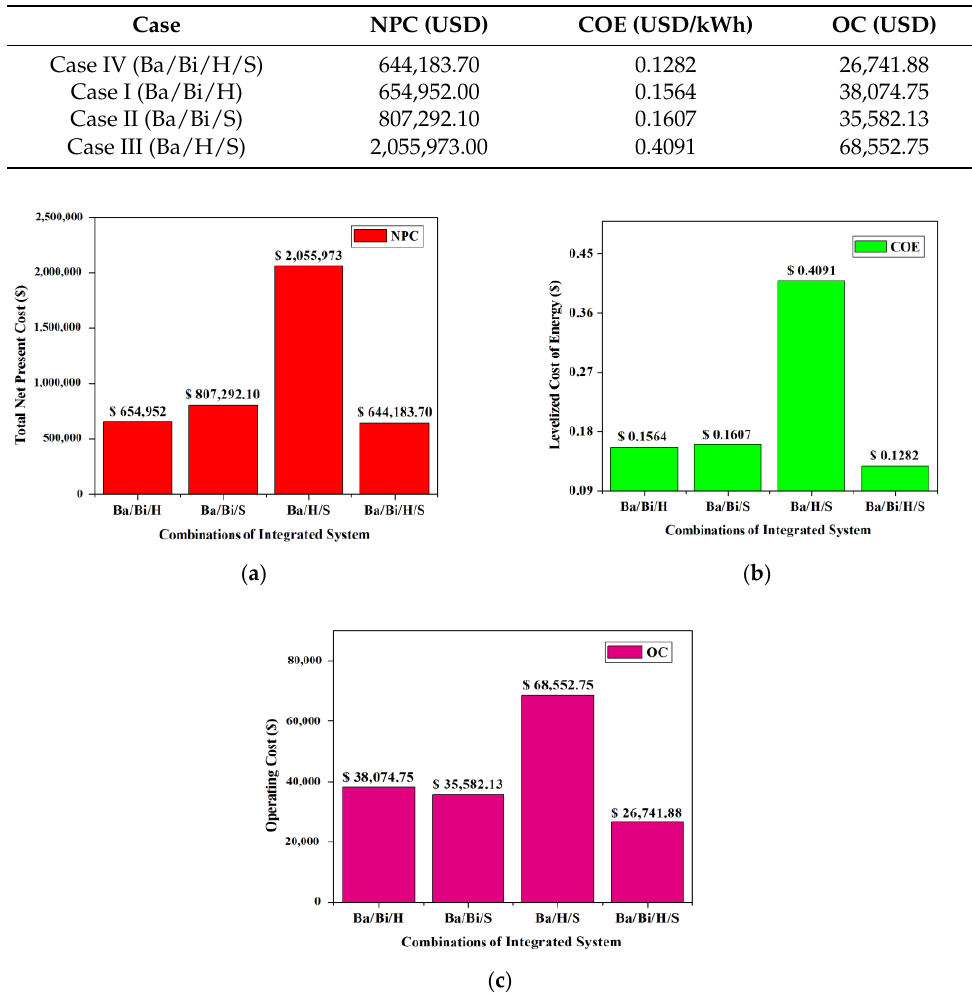
Figure 31. Comparative bar-plot representation of economical indicators ( a ) NPC, ( b ) COE and ( c ) OC for cases I to IV.